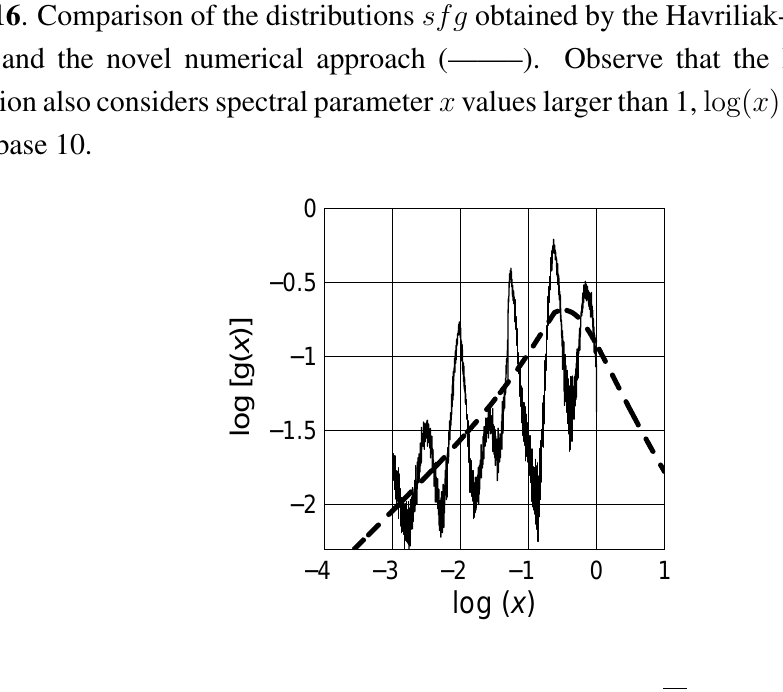
Figure 17 . The most probable values of constants q and ξ from application of the s Havriliak-Negami expression. The integral of g ( x ) yields the concentration of the inclusions q , denoted by open squares ( (cid:3) ) . The percolation strength is ξ , denoted by open circles ( ◦ ). + q , denoted by stars ( (cid:70) ), leads to the actual concentration, The sum of the two constants, ξ s which is denoted with the solid line